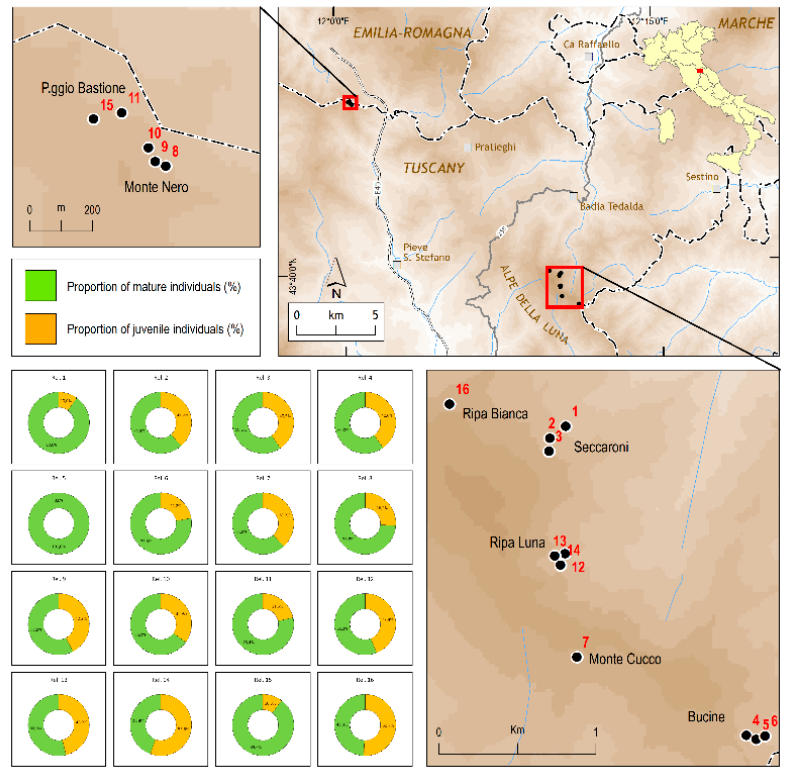
Figure 1. Distribution and size of the 16 localities where Cirsium alpis-lunae was found. The numbers reported on the map (red font) and the graphs (at the bottom left) indicate the different localities where Cirsium alpis-lunae grows and coincide with the numbers indicated in Table 1 (see this table for ecological and populational details of each locality).